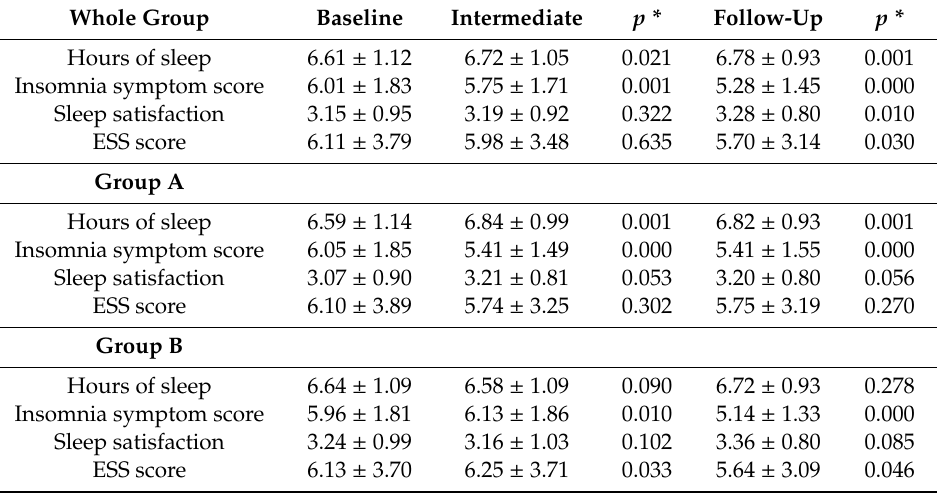
Table 2. Changes of sleep variables during the